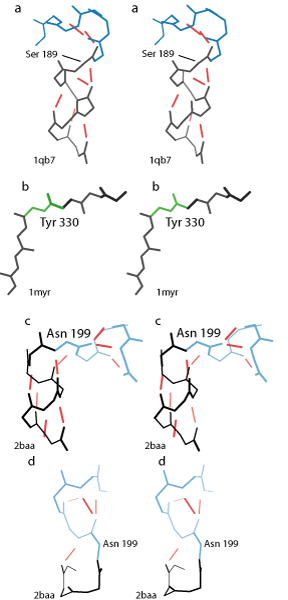
Examples of secondary structural elements showing extreme curvature, which are most likely to be due to mis-assignment of the secondary structure (a) 1qb7 (b) 1myr (c) and (d) 2baa. (c) and (d) show different views of the same region of the protein. In all cases all residues shown are assigned to be in continuous secondary structures by DSSP and STRIDE. SEGNO assignments are shown in black. Hydrogen bonds are shown in red. Figures are shown as stereo pairs.